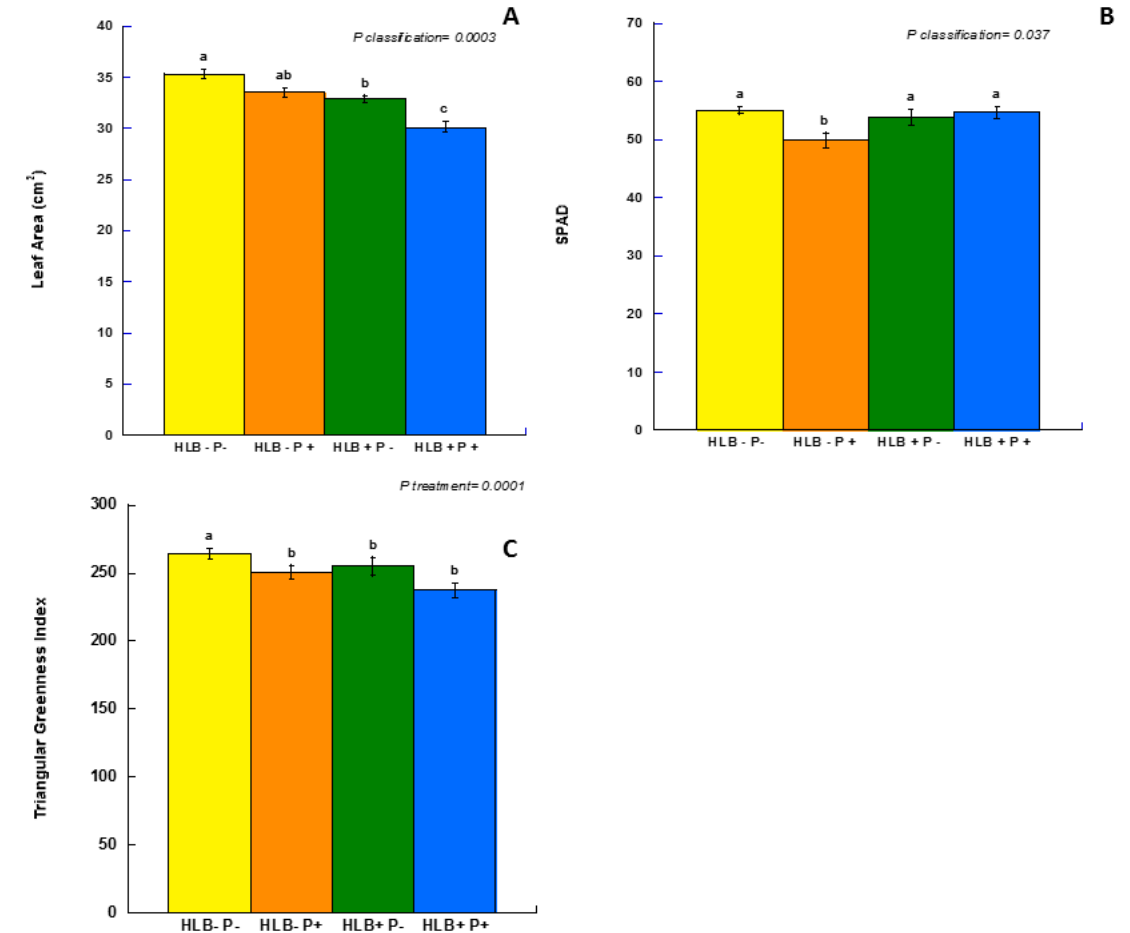
Figure 2. Field measurements of selected citrus trees according to disease status, ( A ) Average leaf area of trees in di ff erent disease classes, ( B ) Average SPAD of trees in di ff erent disease classes, ( C ) Average greenness index (TGI) of trees in di ff erent disease classes as calculated from the UAV images. Error bars are ± 1 standard error of the mean. Di ff erent letters represent significant di ff erences as determined by Students t. p -values for significant treatments are represented as “ p classification or p